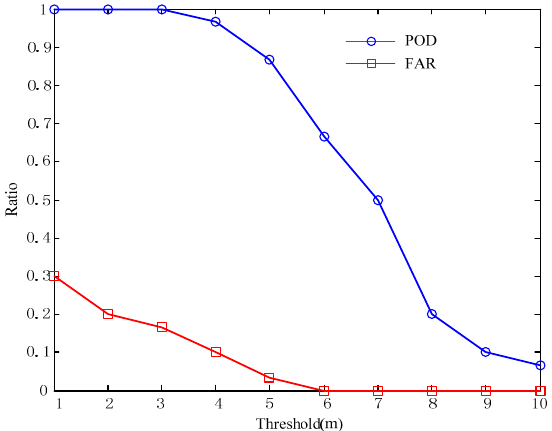
Figure 6. The Probability of Detection (POD) and the False Alarm Rate (FAR) curves. The x -axis denotes the threshold over which a line segment is identified as a corridor-walk.